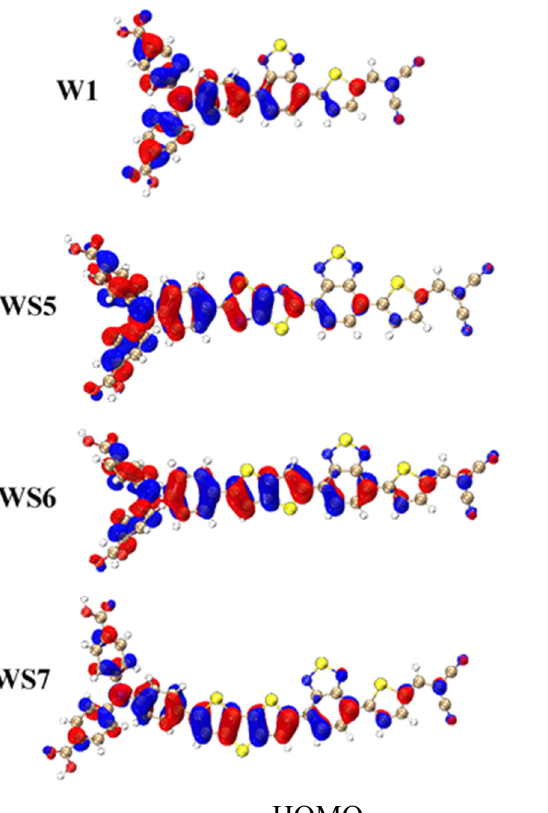
Figure 3. Frontier molecular orbital energy level diagrams of W1, WS5, WS6, and WS7.